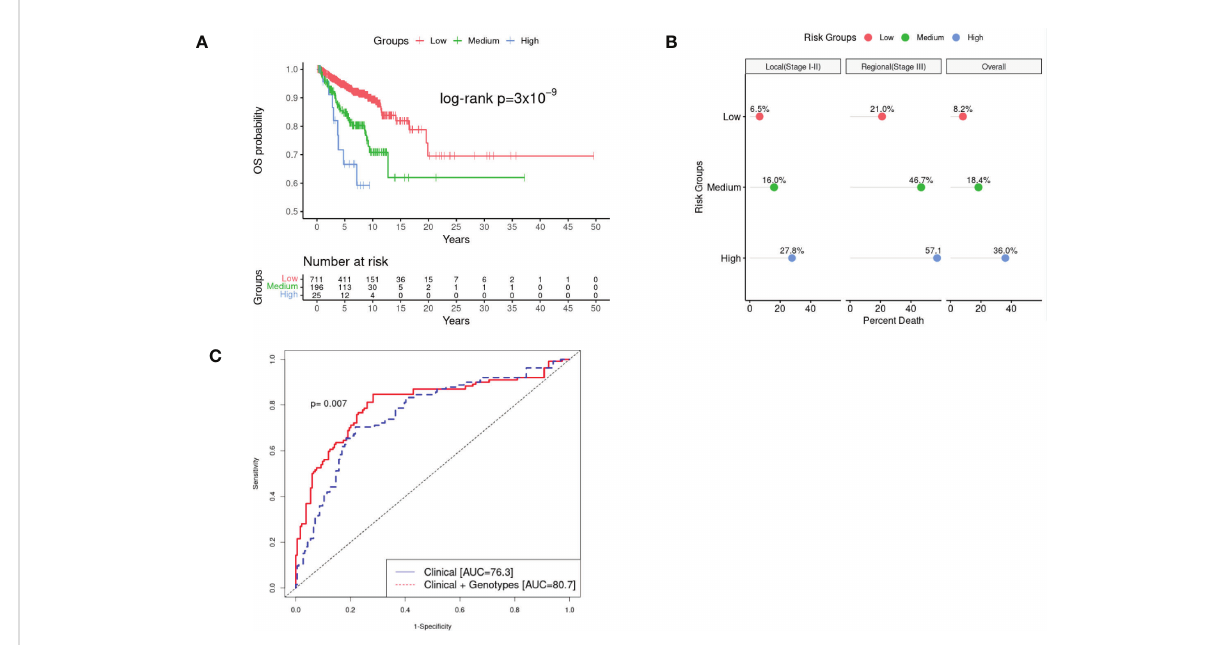
FIGURE 1 Kaplan-Meir survival (KM) curves, percentage of overall mortality, and estimated Area under the Curve (AUC) of the combined effect of rs77480547 and rs60970102 on CM OS detected in the GWAS study. Panel (A) plotted the survival curves of patients strati fi ed by low risk (CRA=0), medium risk (CRA=1) and high risk (CRA>1) groups. We noted a clear dosage pattern of CRA effect on OS, further illustrated in Panel (B) by the linear increase in proportion of death as the CRA increased, for both local (stage I-II) and regional (stage III) disease over the